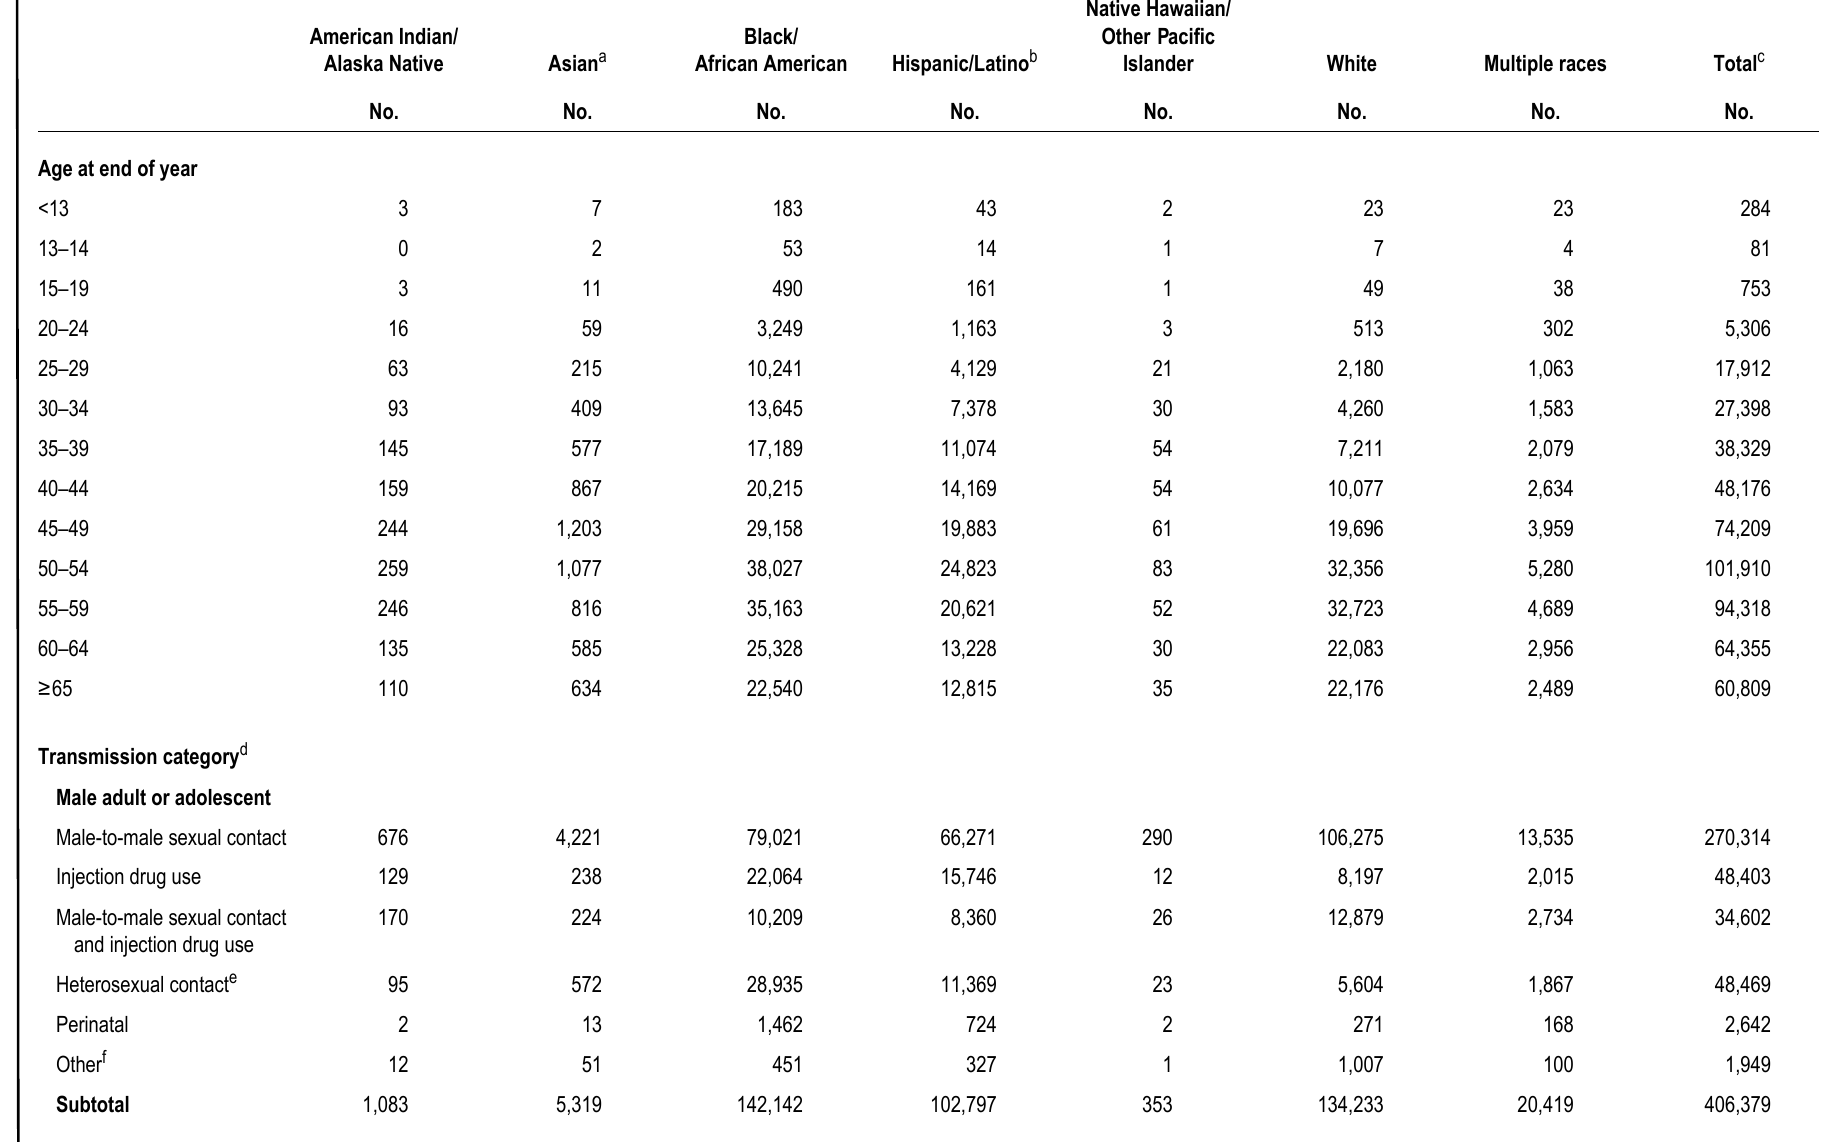
Table 25b. Persons living with diagnosed HIV infection ever classified as stage 3 (AIDS), by race/ethnicity and selected characteristics, year-end 2017—United States and 6 dependent areas Native Hawaiian/ American Indian/ Black/ Other Pacific Alaska Native Asian a African American Hispanic/Latino b Islander White Multiple races Total c No. No. No. No. No. No. No.